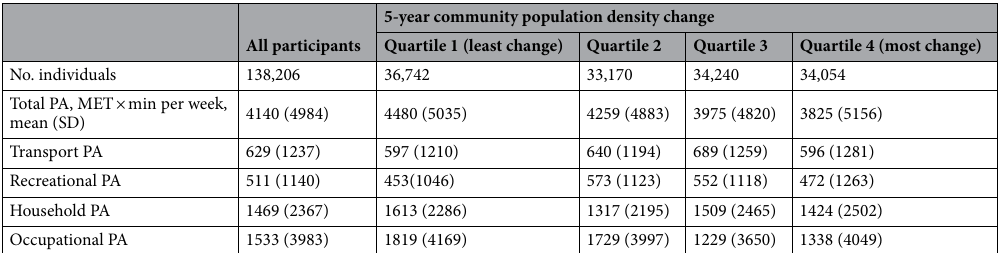
Table 2. Participant physical activity levels stratified by quartiles of 5-year community population density change.